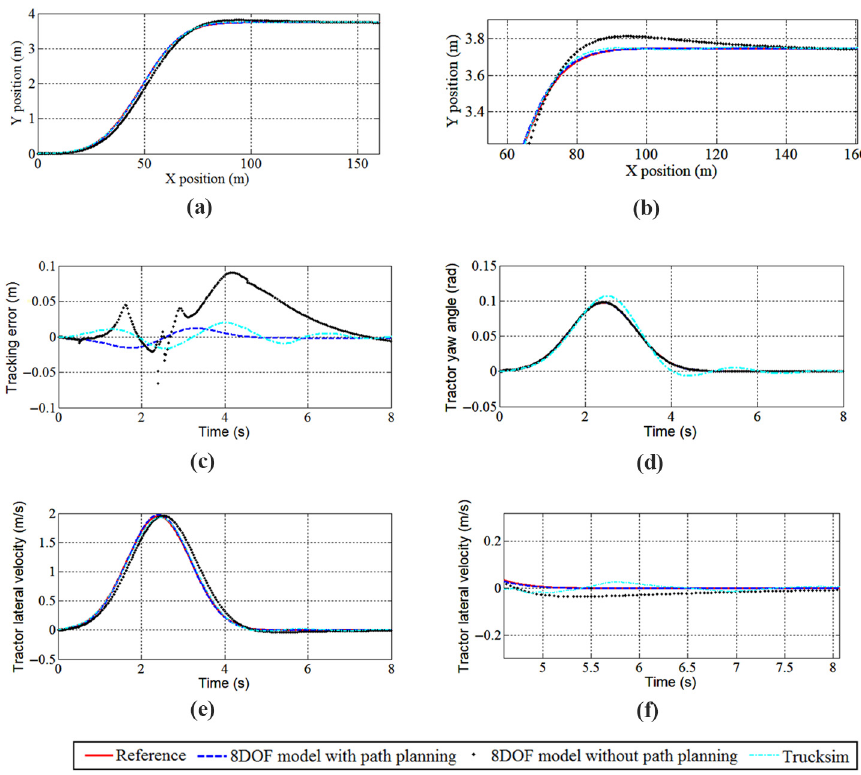
Figure 9 Model comparative study for the combined